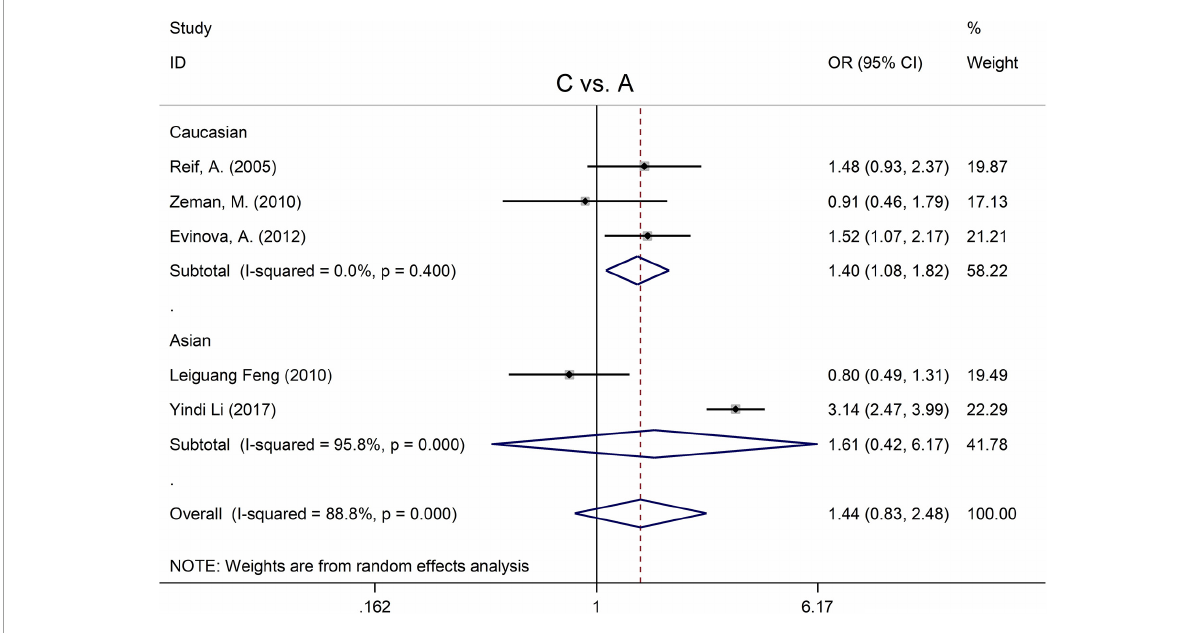
FIGURE5 Forest plots for the associations between MTHFR A1298C polymorphisms and MD for the allele model with random effect model.